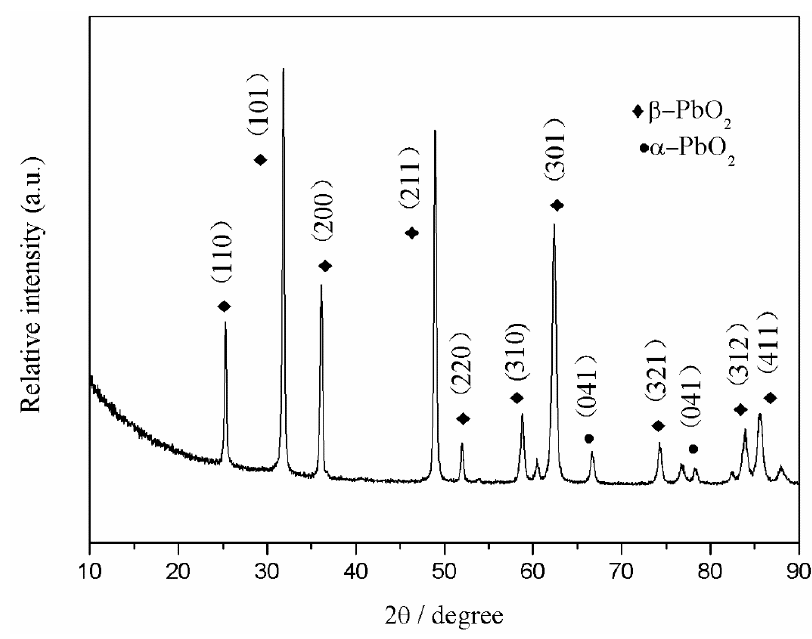
Figure 3. The X-ray diffraction (XRD) pattern of 150 µm porous Ti/SnO 2 –Sb 2 O 3 /PbO 2 electrode.